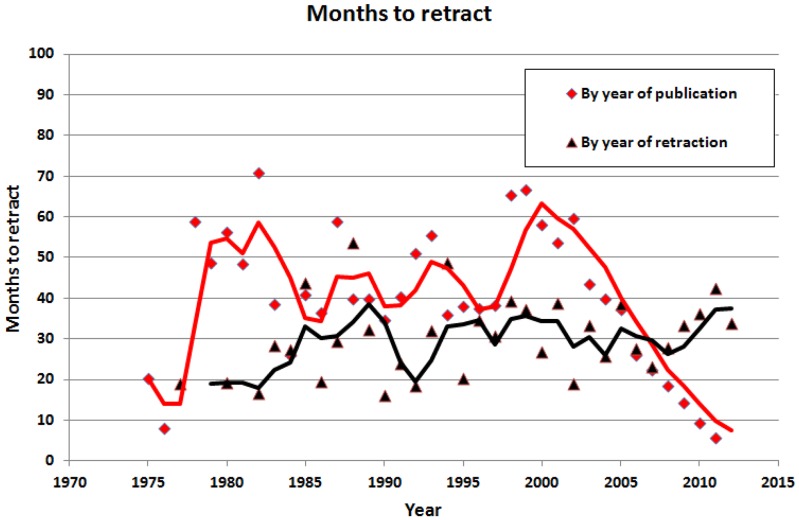
Months to retract by year of publication and by year of retraction.The fitted lines are 3-year moving averages of the plotted points. Apparent declines in recent years must be interpreted with caution as additional papers may be retracted in the future, thereby reversing this decline.